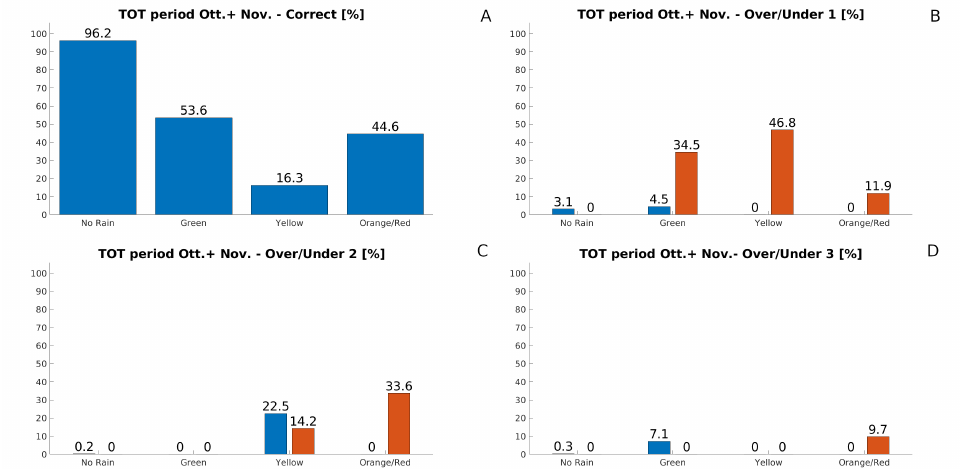
Figure 8. Performance obtained using only a single run corrected with Phast. In panels ( B – D ), overestimations are represented in blue and underestimations are represented in orange, panel ( A ) represents the correct forecast